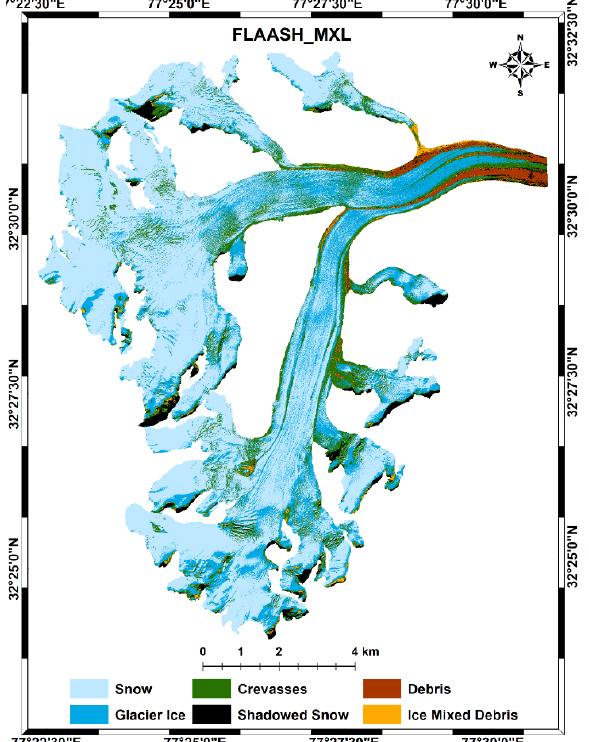
Figure 7. Thematic classification results of the MXL algorithm for the FLAASH atmospheric correction for the ML glacier.